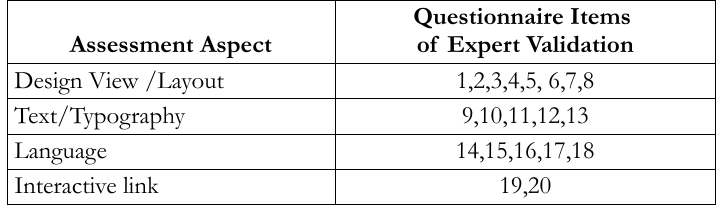
Table 1. Questionnaire of Expert Validation